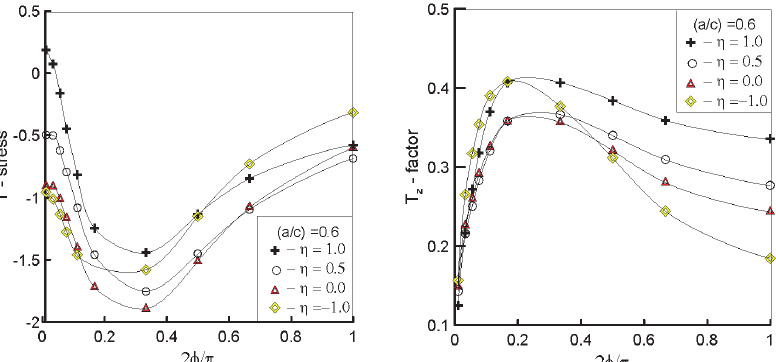
Figure 6: Elastic constraint parameter distributions along crack front under different biaxial loading